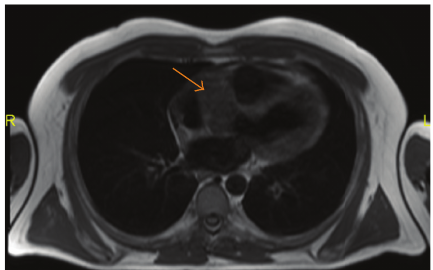
Figure 12: A 35-year-old male with non-fat-saturated T2-weighted image showing a lesion (arrow) abutting the right atrium that is hyperintense to the surrounding